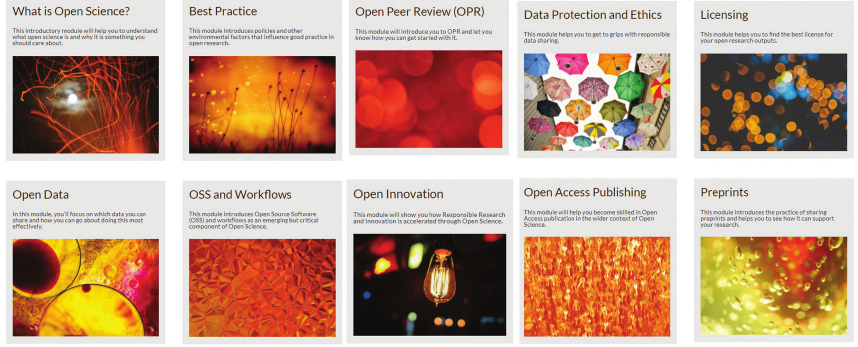
Fig. 4: The Open Science